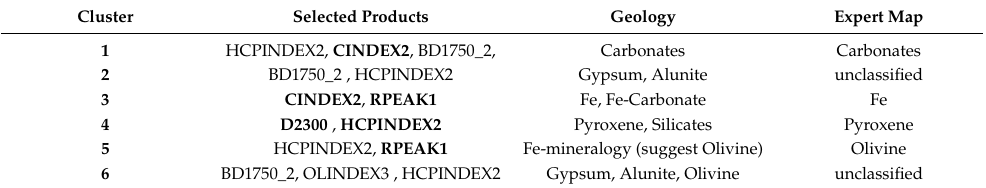
Table 2. Quantitative geological mapping of the six identified regions for the Jezero Crater (HRL000040FF). The products conforming to the expert map (cf. Figure 4a) are in bold, accord- ing to Viviano et al.